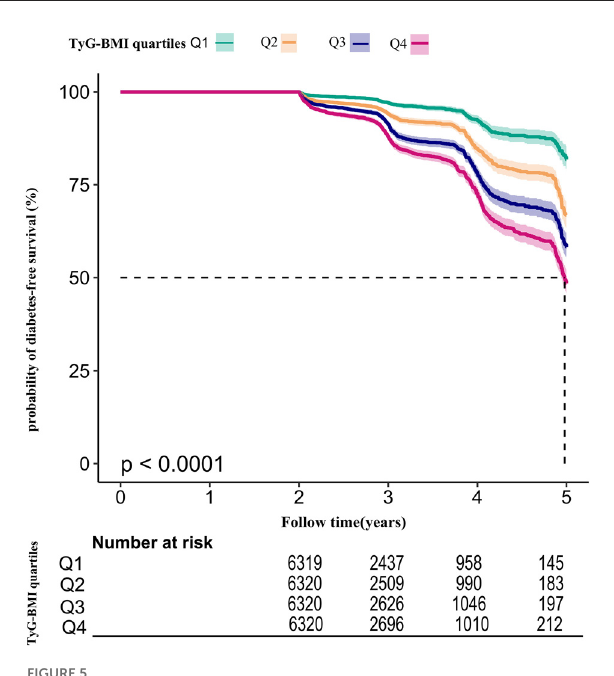
FIGURE5 Kaplan–Meier event-free survival curve. Kaplan–Meier event-free survival curve. The probability of diabetes-free survival differed significantly between the TyG-BMI quartiles (log-rank test, p < 0.001). The probability of diabetes-free survival gradually decreased with increasing TyG-BMI, suggesting that the group with the highest TyG-BMI had the highest risk of diabetes.